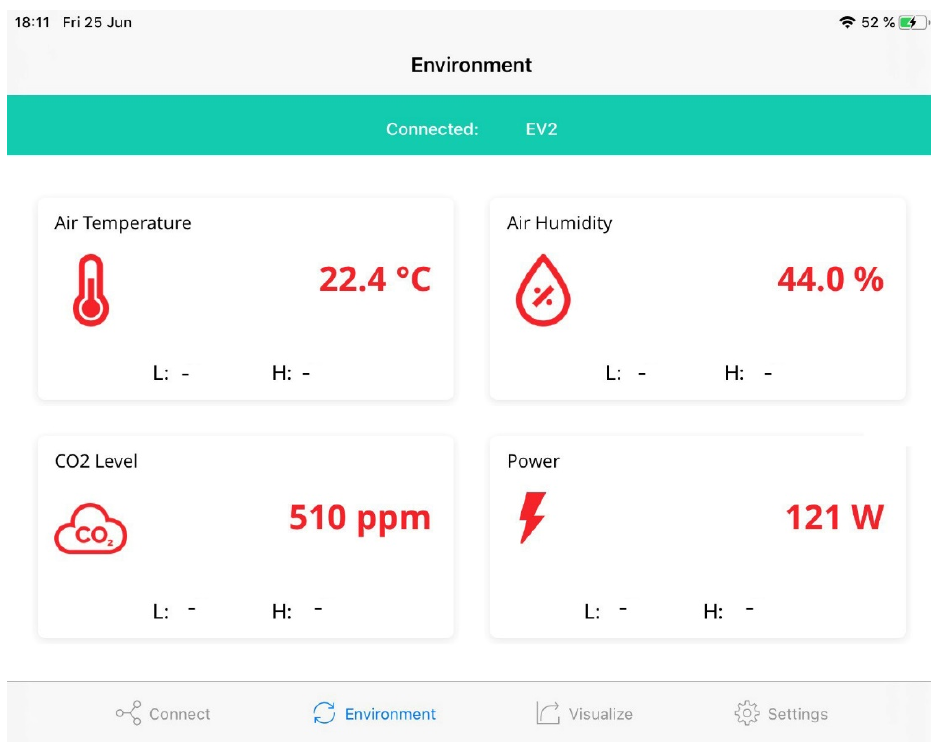
27 of 36 Figure 32. PWL representations of the optimal load profiles (magenta—aggregated profile based on the shifting configuration resulted from the PWL approximation, blue—aggregated profile